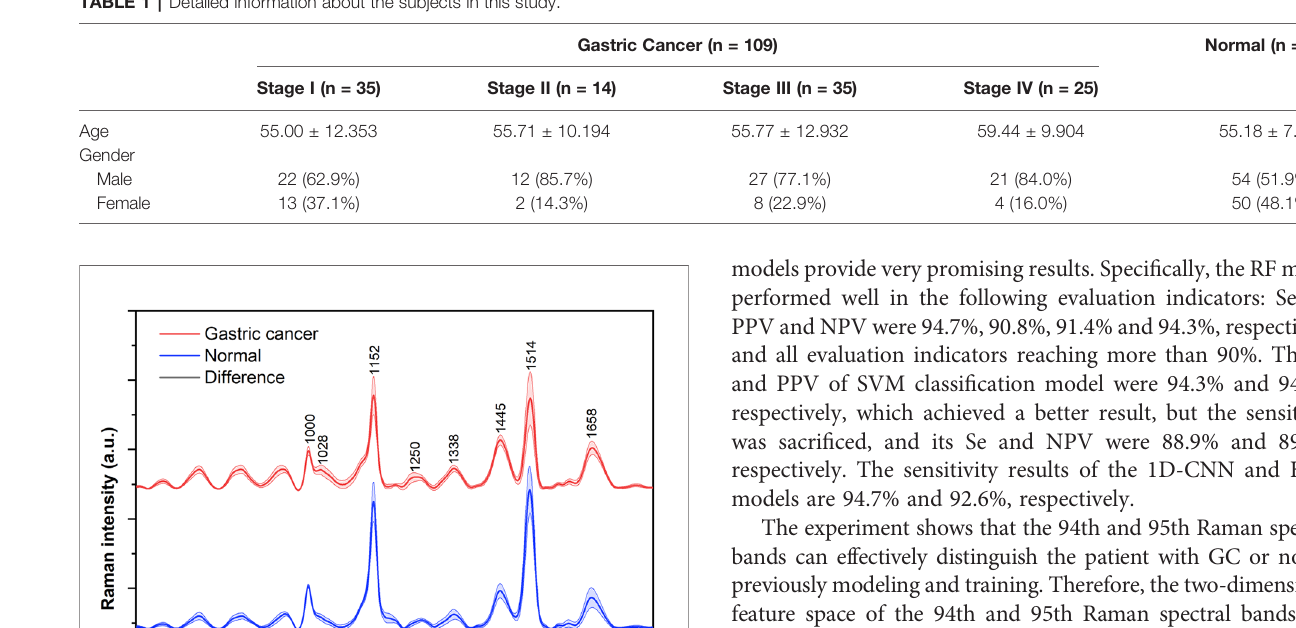
TABLE 1 | Detailed information about the subjects in this study.